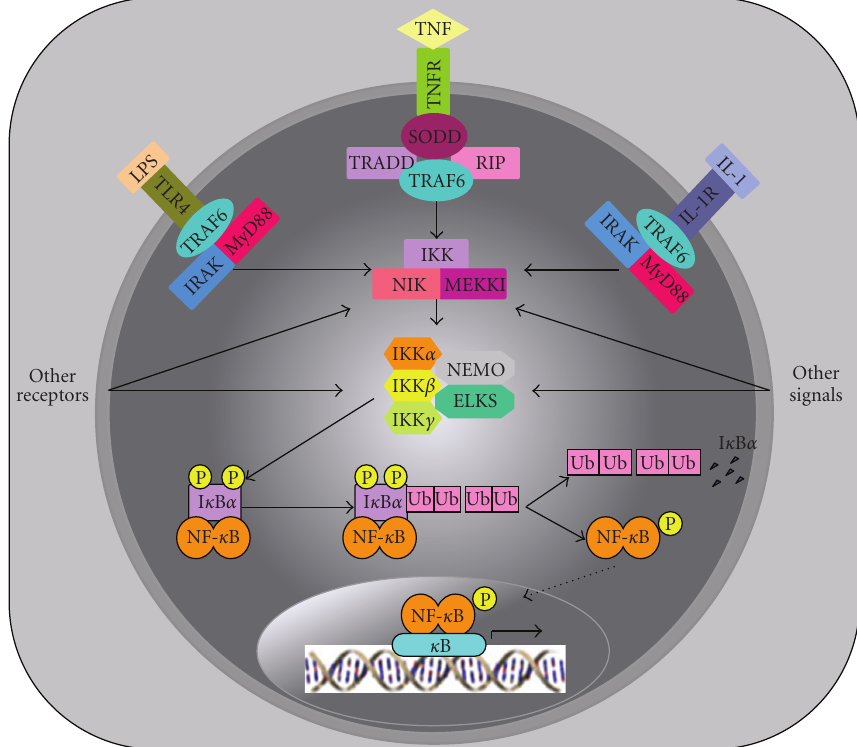
Figure 2: NF- κ B Signaling Pathway. A cartoon representing the cascade of biochemical events that are initiated by various stimuli, eventually leading to NF- κ B nuclear translocation and transcriptional activation. Recruitment of di ff erent adaptor molecules to di ff erent receptor complexes coupled with activation of di ff erent downstream kinases is shown. There are mainly two signaling pathways leading to NF- κ B activation, classical (also known as canonical) and alternative. The formation and activation of the IKK complex, which consists of catalytically active kinases (e.g., IKK α , IKK β , and IKK γ ) and noncatalytic regulatory proteins (e.g., NEMO and ELKS), is a universal event in both signaling pathways. In the classical signaling pathway, ligand binding to a cell surface receptor leads to the recruitment of adaptor proteins (e.g., TRAF6) to the receptor, leading to the recruitment of IKK complex and subsequent phosphorylation and degradation of the I κ B proteins. Unlike the classical signaling pathway, the alternative signaling pathway, which is normally triggered by non-proinflammatory cytokines (e.g., LT β , BAFF, and CD40L) as well as some viruses (e.g., HTLV and EBV), does not allow the recruitment of NEMO. Instead, ligand binding to a cell surface receptor leads to the recruitment of NIK, which in turn phosphorylates and activates IKK α dimers. Typically, the classical signaling pathway leads to the activation of NF- κ B dimers consisting of RelA, c-Rel, RelB, and p50, while the alternative signaling pathway leads to the activation of NF- κ B dimers consisting primarily of RelB and